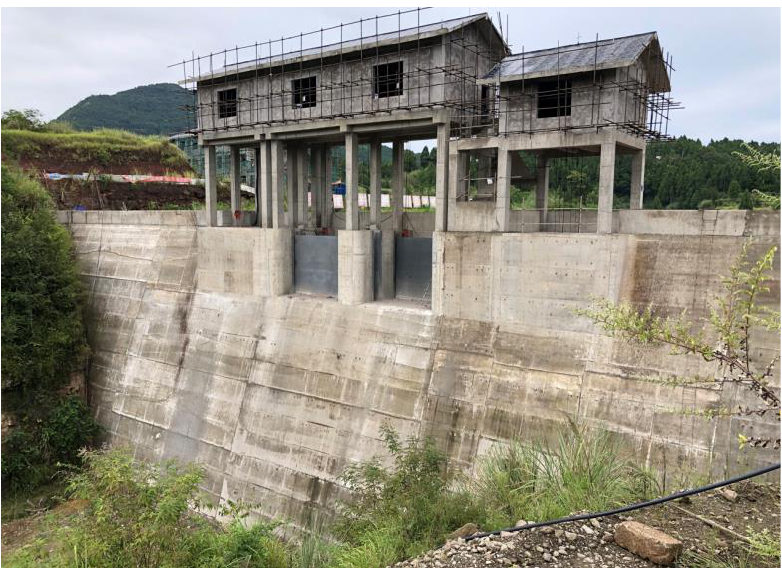
Figure 5. Jinjigou cemented soft rock dam.